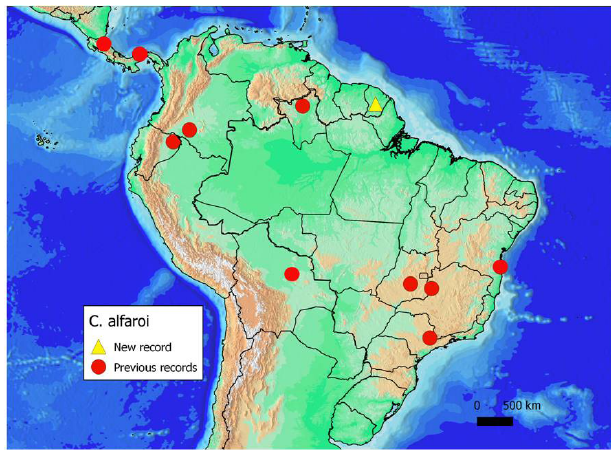
Fig 3 . Distribution map of Centromyrmex alfaroi in the Neotropics based on literature records and the present